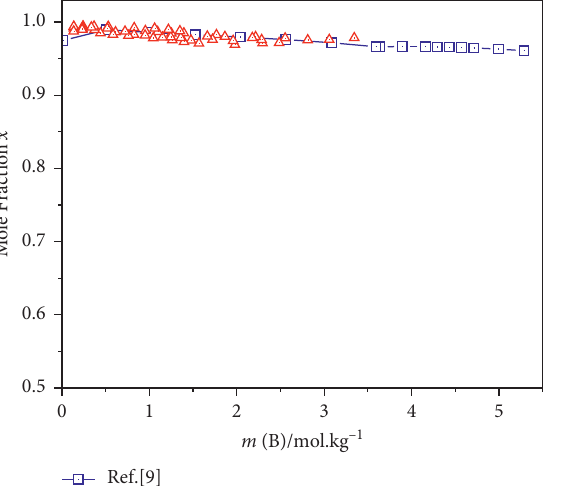
− in the system NaBO 4 2 –Na 2 SO 4 –H 2 O at 298.15K calculated in this work and with the